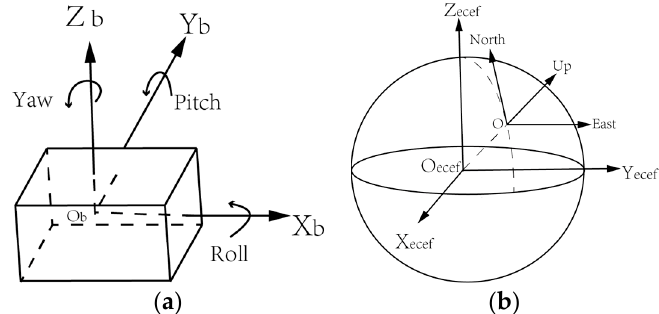
Figure 2. Sketch map of sensor body coordinate frame (b-frame) and navigation coordinate frame (n-frame). ( a ) Shows the b-frame and three Euler angels which are yaw, pitch and roll; ( b ) shows the relation between earth-centered, earth fixed (ECEF) coordinate system and east-north-up (ENU) coordinate system. ENU is better to be applied in our system than ECEF because that it has the same origin with b-frame. Therefore, the rotation matrix will be simpler.